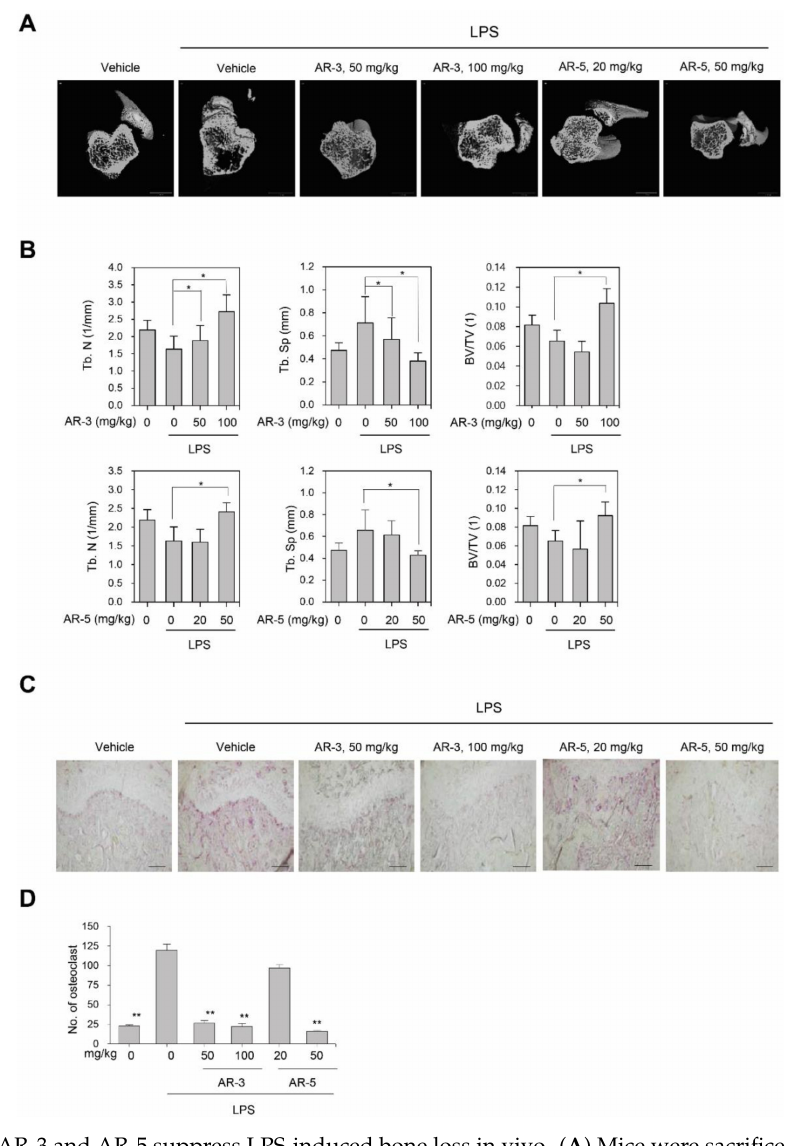
Figure 4. AR-3 and AR-5 suppress LPS-induced bone loss in vivo. ( A ) Mice were sacrificed nine days after the first LPS injection, and three-dimensional images of femurs were obtained using µ CT (scale bar: 1 mm). ( B ) Trabecular number (Tb. N), trabecular separation (Tb. Sp), and trabecular bone volume / tissue volume (BS / TV) were analyzed using the CTAn software. n = 4 in each group (eight legs). * p < 0.05, versus the LPS-treated control. ( C ) Fixed femurs were decalcified and sectioned. Sections were stained with TRAP (200 × ). Scale bar: 100 µ m. ( D ) The number of TRAP-positive osteoclasts was counted. Data are presented as the mean ± SE (** p < 0.01, versus the LPS-treated